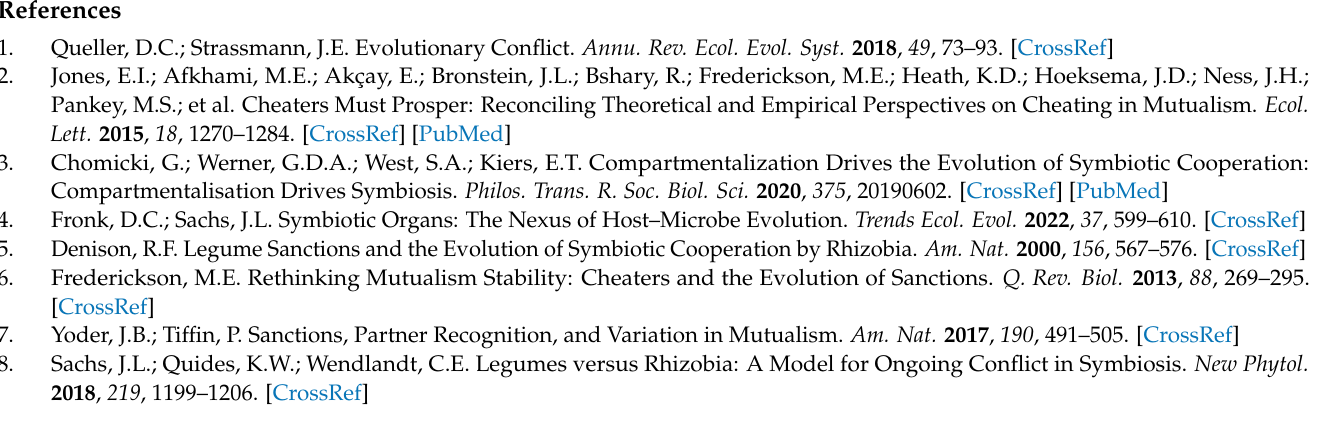
Figure S2: Colony-forming units vs. quantitative polymerase chain reaction in vitro; Figure S3: Bland–Altman plots to compare population proportion estimates by colony-forming units and quan- titative polymerase chain reaction; Figure S4: Colony-forming units vs. quantitative polymerase chain reaction in planta; Figure S5: wild type and mutant qPCR cell estimates while passaging in growth pouches; Figure S6: Passaging in germination pouches; Table S1: Primers used in this study, all the data generated in this study; Figure S7: Wild type and mutant qPCR cell estimates while passaging in magenta boxes; Figure S8: Mutant qPCR cell estimates while passaging in magenta boxes; Figure S9: Wild type and both mutant qPCR cell estimates while passaging in magenta boxes. Code S1: The R scripts used for data analysis and generating